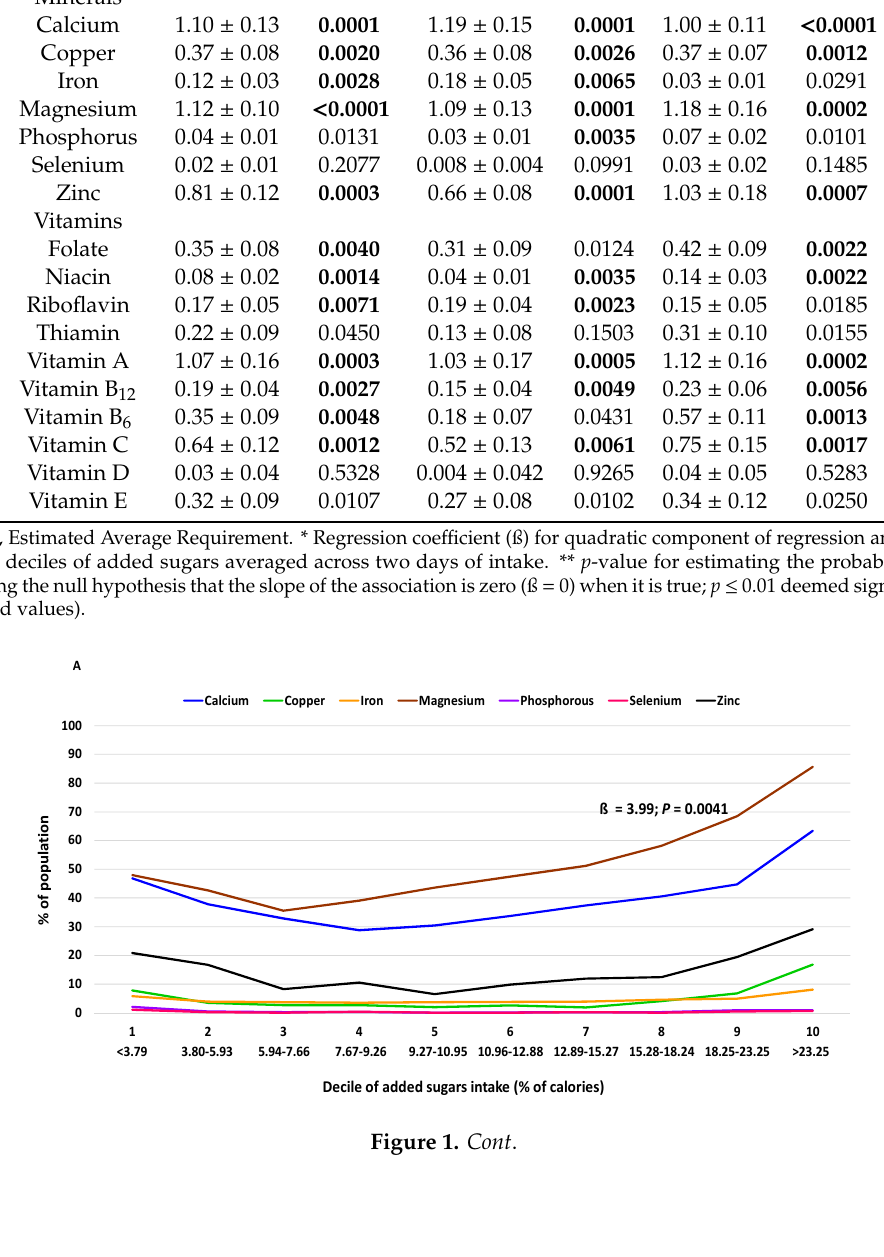
Figure 1. Percentage of adults 19+ y (NHANES 2009–2014) with micronutrient intakes below the EAR for ( A ) minerals and ( B ) vitamins per decile of added sugars intake (% of calories) averaged across two days of intake using regression analysis (ß: regression coefficient). Association deemed significant at p < 0.01. EAR, Estimated Average Requirement; Vit, vitamin.